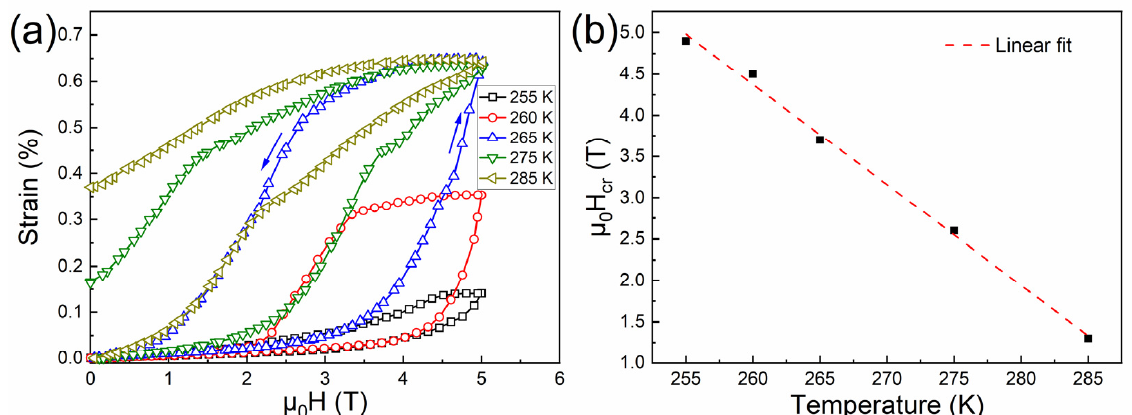
Figure 6. ( a ) Field dependence of magnetostrain for the alloy after superelastic training at selected temperatures with a maximum magnetic field of 5 T. ( b ) Temperature dependence of critical magnetic field ( μ 0 H cr ) to drive the reverse martensitic transformation for the alloy after superelastic training.